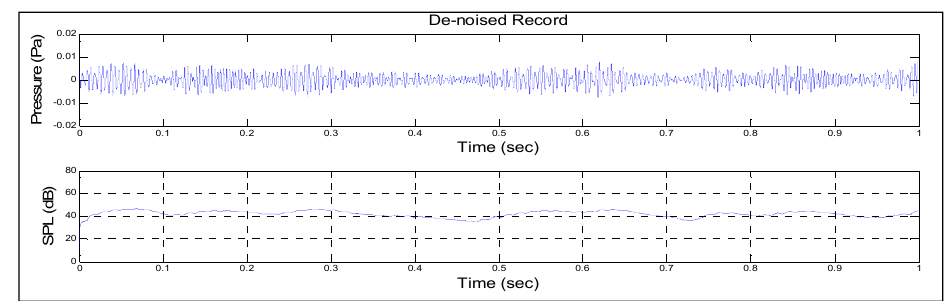
Figure 9. Reconstructed series vs original noisy signal and residual series.